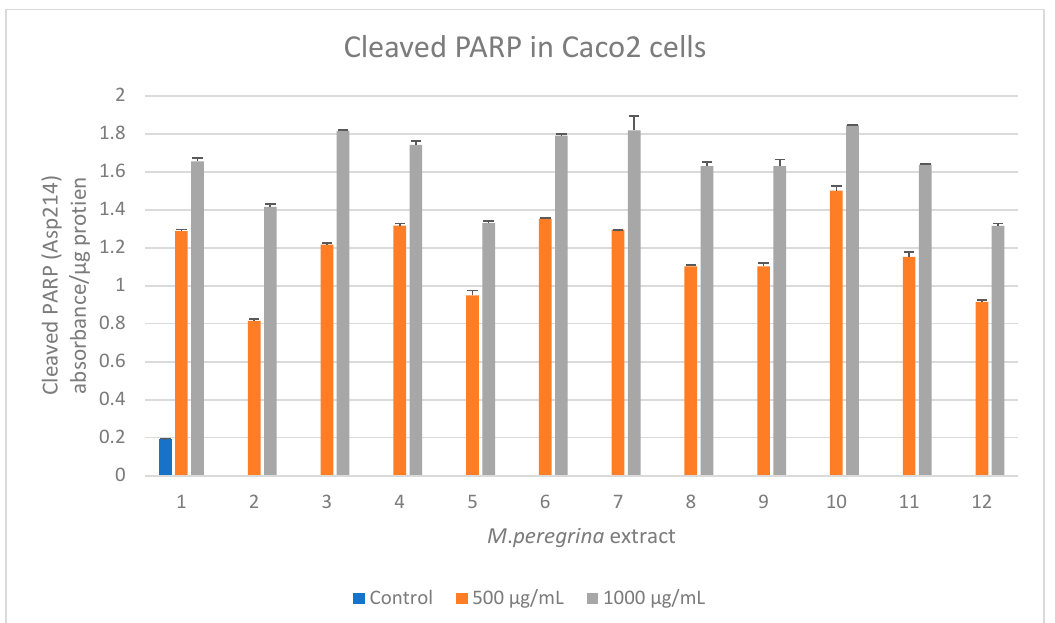
Figure 7. Graphical representation of cleaved PARP in the different M. peregrina extracts on Caco-2 with 72 h incubation: ‘1’—Hexane extract (tubers); ‘2’—chloroform extract (tubers); ‘3’—acetone extract (tubers); ‘4’-methanol extract (tubers); ‘5’—hexane extract (leaves); ‘6’—chloroform extract (leaves); ‘7’—acetone extract (leaves); ‘8’—methanol extract (leaves); ‘9’—hexane extract (stem); ‘10’—Chloroform extract (stem); ‘11’—Acetone extract (stem); ‘12’—Methanol extract (stem). One way ANOVA analysis to compare between control, 500 and 1000 µ g/mL of the extract ( p < 0.005).